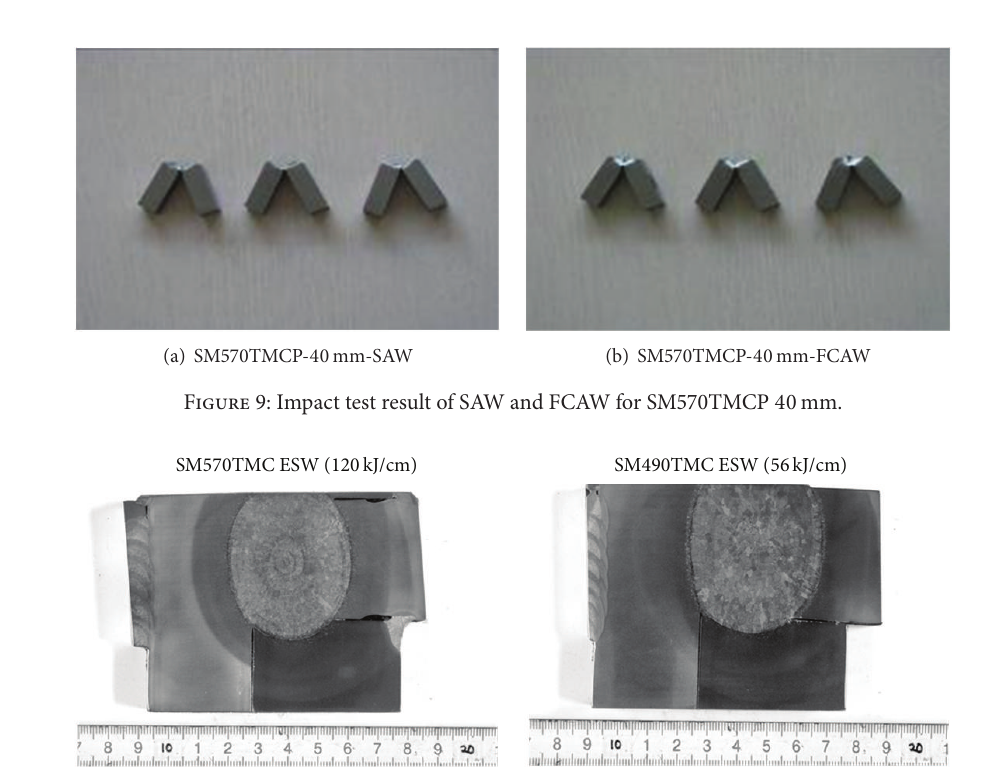
Figure 8: Impact test result of SM570TMCP and SM490TMCP welding part.